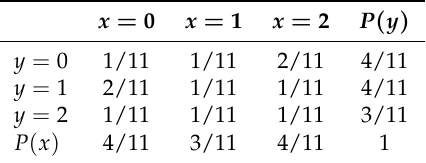
Table 5. Joint probability distribution for two variables x and y that can assume three states: 0, 1 and 2. x = 0 x =